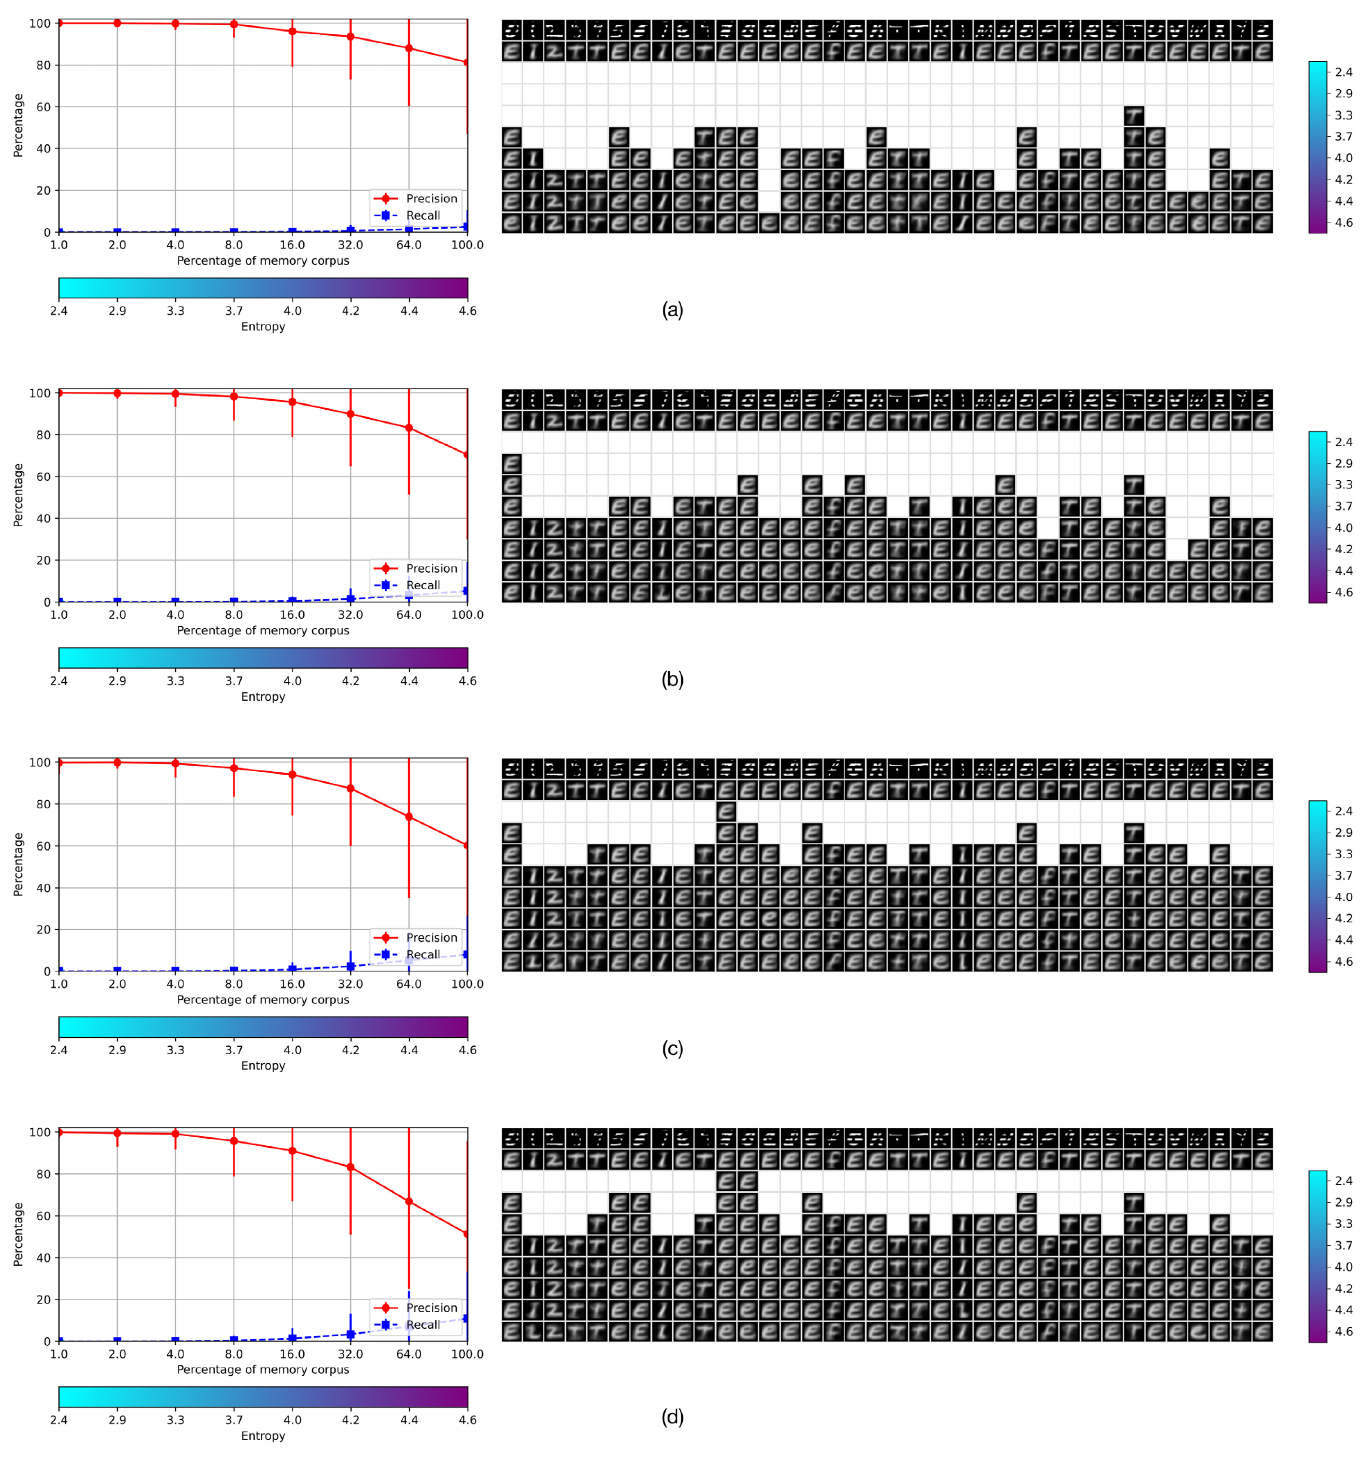
Fig 13. Memory retrieval using cues occluded with horizontal bars. Results with relaxations of none, 1, 2 and 3 features out of 64.